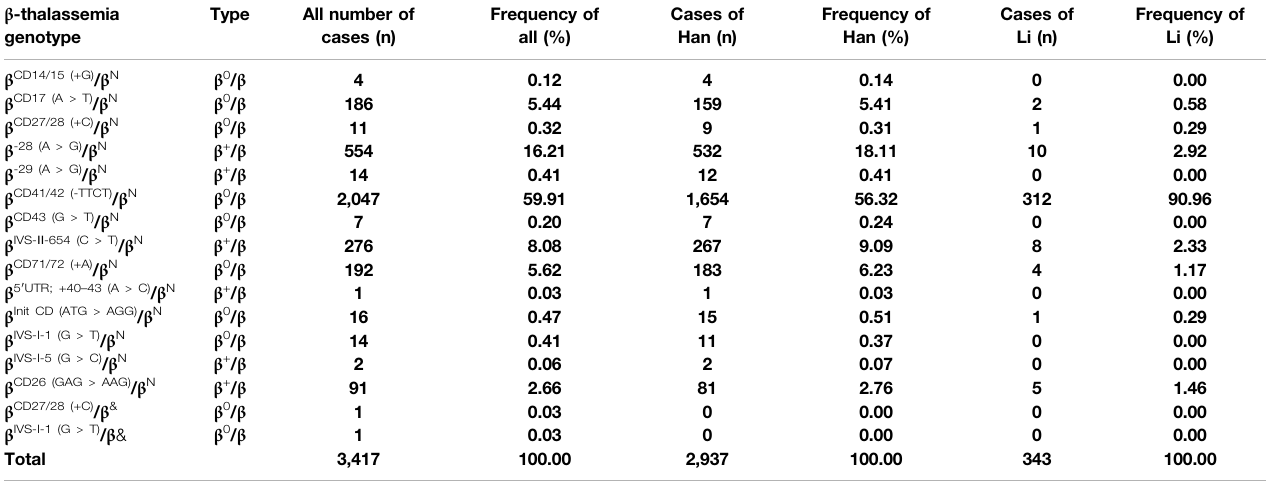
TABLE 2 | Molecular mutation spectrum of β -thalassemia in the population of childbearing age in the Hainan Island. β -thalassemia